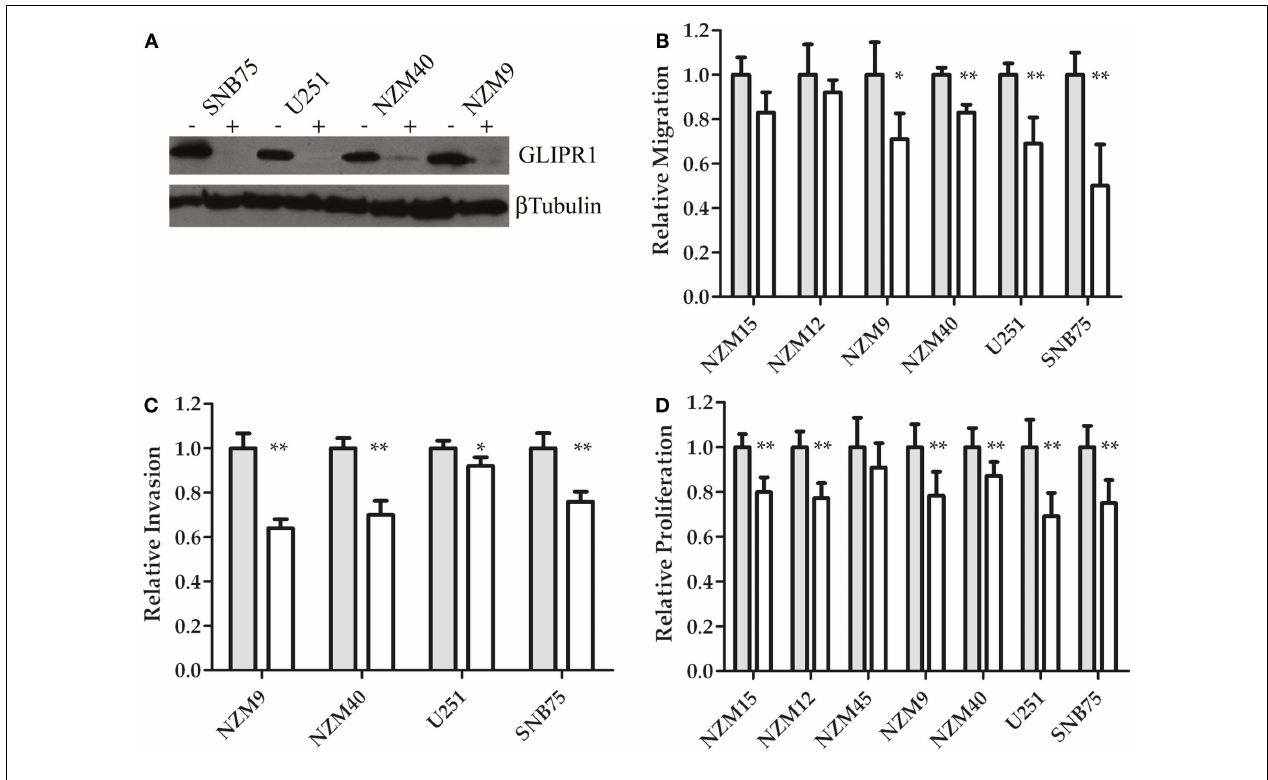
average number of cells per field of view ± SEM from three (B) or two (C) independent experiments. Error bars indicate SEM; * p < 0.005, ** p < 0.001. No migration was observed for NZM45 ( Figure 2A ) and no invasion was seen for NZM45, NZM12, or NZM15 ( Figure 2B ). (D) Cell proliferation was quantified using MTT-based colorimetric assay. Results are mean of two independent experiments, n = 4. Results in (D) are shown as data for cells 4days after transfection with siGLI relative to data for cells transfected with siNT. Results for (B,C) are shown for cells 24h following